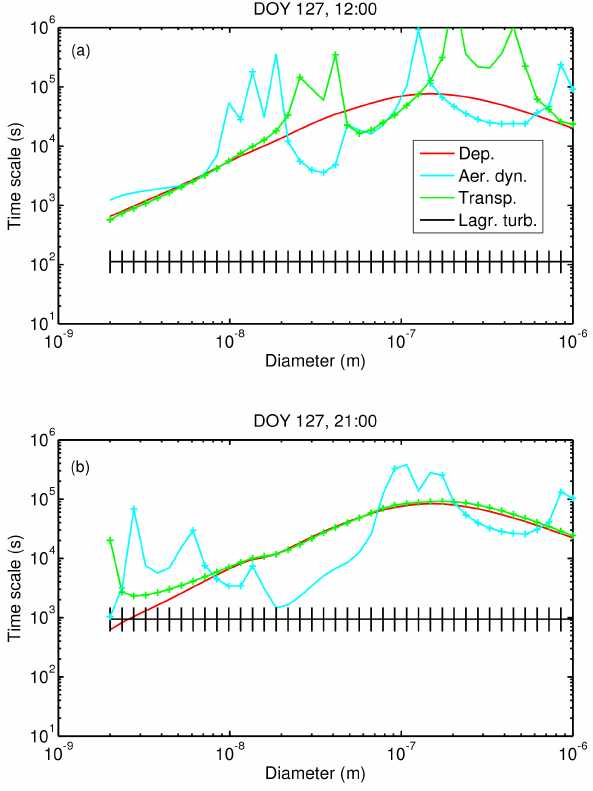
Figure 7. The timescales of deposition, aerosol dynamics and trans- port (equivalent to vertical exchange) as defined by Eq. (9) together with Eqs. (5), (6) and (7) at (a) 12:00LT (the values for the trans- port term are out of scale at about 200 and 450nm, being about + 3 . 7 × 10 6 and − 1 . 05 × 10 6 s, respectively) and (b) 21:00LT on 7 May 2013. In addition the Lagrangian timescale for turbulent transfer (corresponding to aerodynamic resistance only) as simu- lated according to Eq. (10), is presented as the median air parcel travel time between the forest floor and the canopy top with upper and lower quartiles. The “ + ” sign reflects the positive sign of the re- spective term (the source), whereas no such sign infers the negative (sink) term.